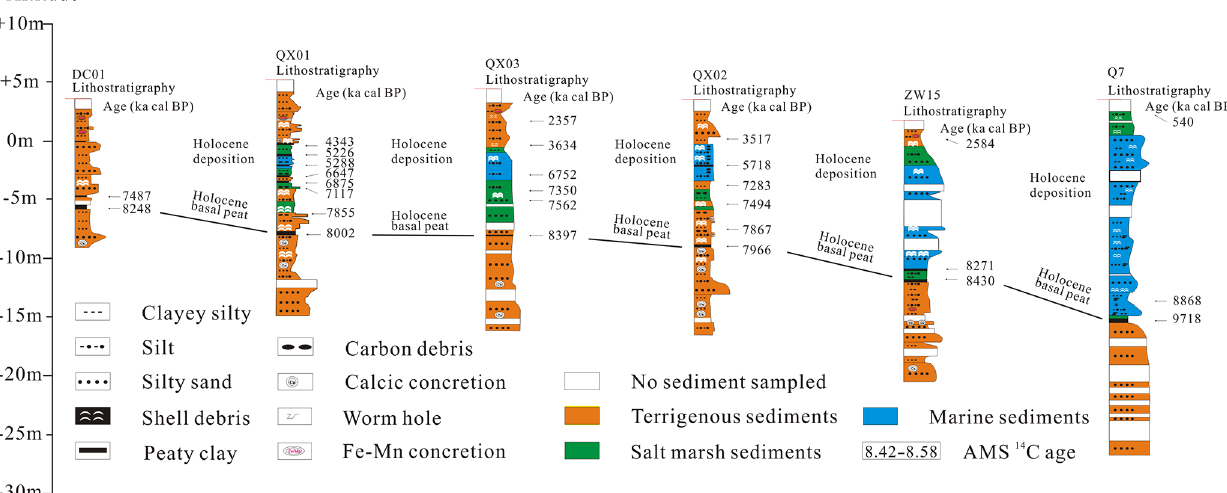
CZ85, CZ66, CZ87, CZ61, CZ65, ZW15 and Q7 – the